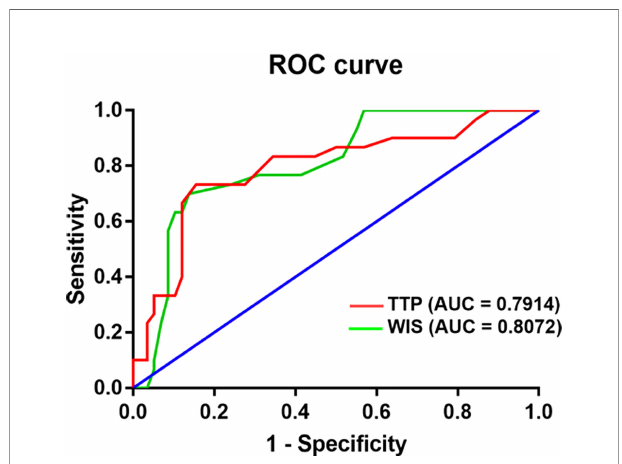
FIGURE 4 | Diagram shows Comparison receiver operating characteristic curve of CEUS between granulomatous lobular mastitis and